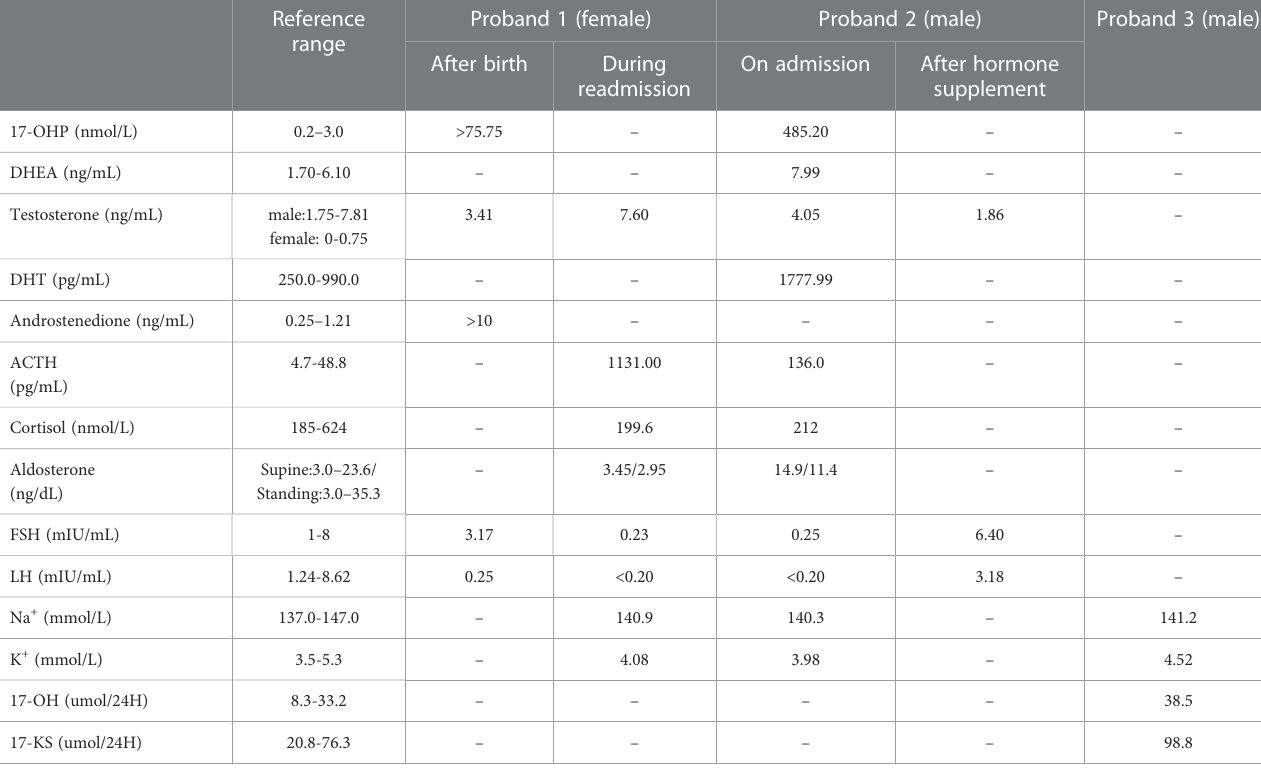
TABLE 1 Laboratory parameters of the